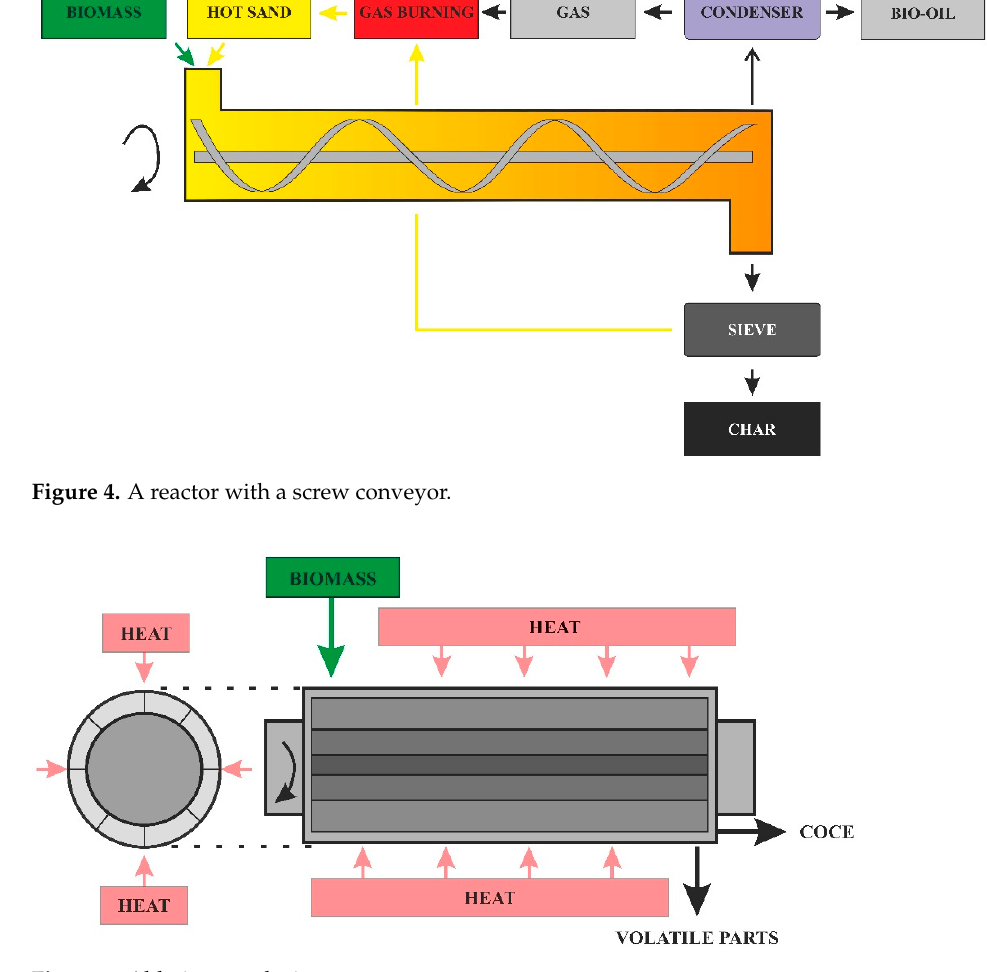
Figure 4. A reactor with a screw conveyor.